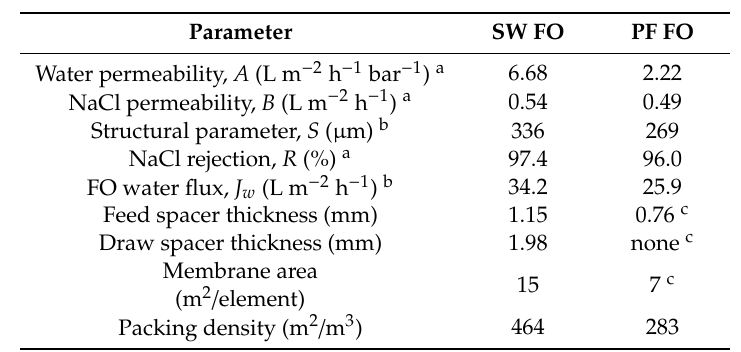
Table 2. The specifications of the spiral-wound (SW) and plate-and-frame (PF) forward osmoses (FO) membrane modules employed in this